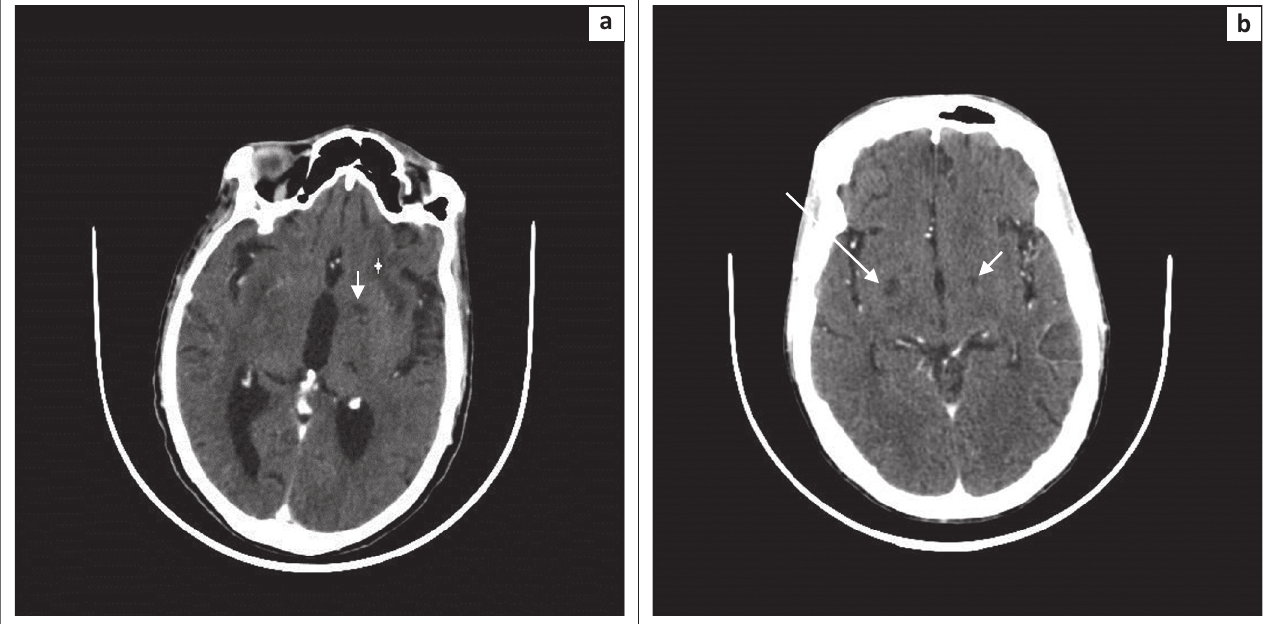
FIGURE 1: (a) Axial computerised tomography scan brain showing dilated Virchow–Robin (VR) spaces (arrow) as small hypodense non enhancing lesions in the left basal ganglia. Note also a larger hypodense lesion in the left external capsule consistent with a gelatinous pseudocyst, in addition, atrophy and mild hydrocephalus; (b) Axial brain scan with a pseudocyst in the right basal ganglia and a dilated VR on the